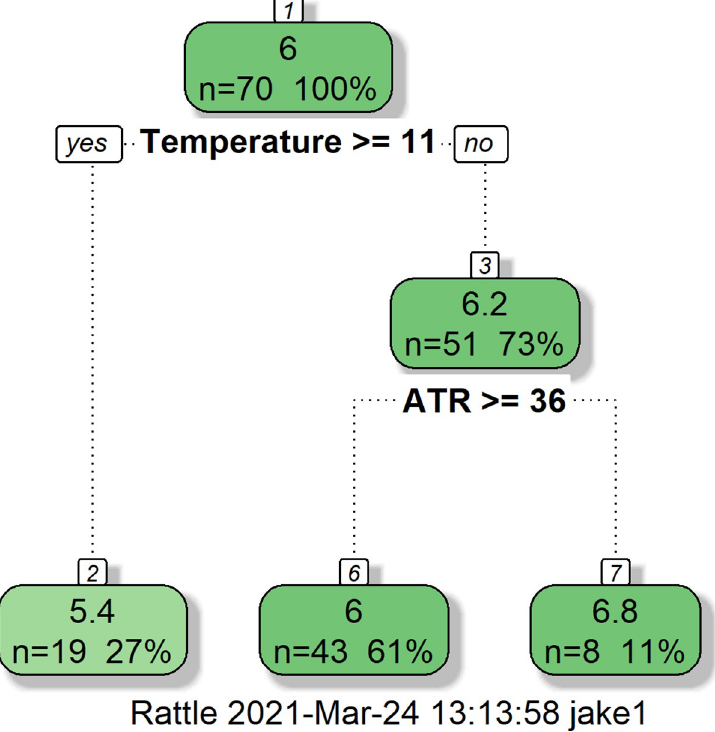
Fig 2. Novel CART model predicting Temperate Deciduous Forest soil pH. See Table 1 for descriptions of all variables.